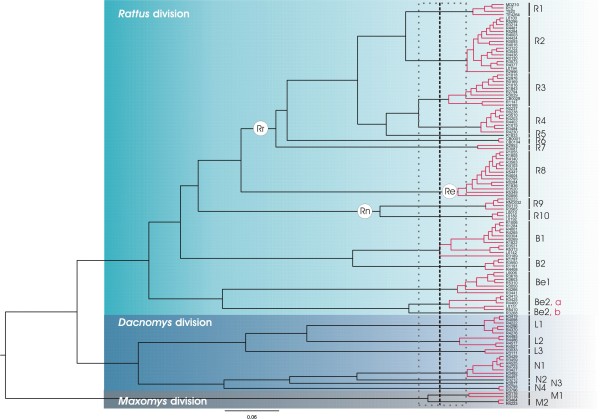
Rattini ultrametric tree obtained with Multidivtime and clusters of specimens recognized as putative species by the method of Pons et al. [28]. Genetic clusters recognized as a putative species are highlighted in red and separated by longer black branches. The vertical bars group all sequences within each significant cluster, labelled R1 to M2 according to the genus to which they belong. Rr for Rattus rattus species group, Re for Rattus exulans species group, Rn for Rattus norvegicus species group.